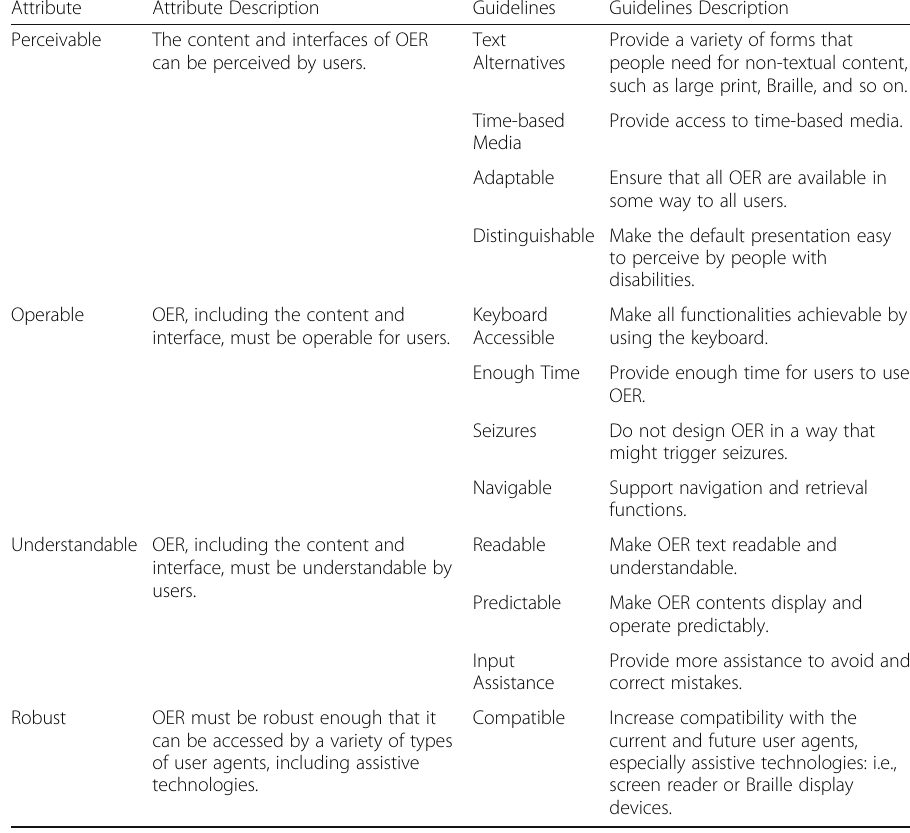
Table 1 Description of the WCAG 2.0 Attribute and Guidelines applied to OER Attribute Attribute Description Guidelines Guidelines Description